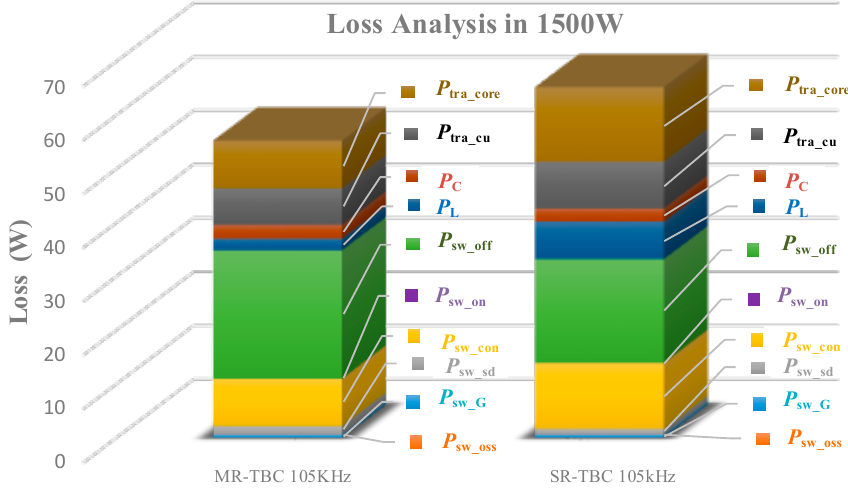
Figure 11. Loss calculation comparison of MR-TBC and SR-TBC under 1500 W.